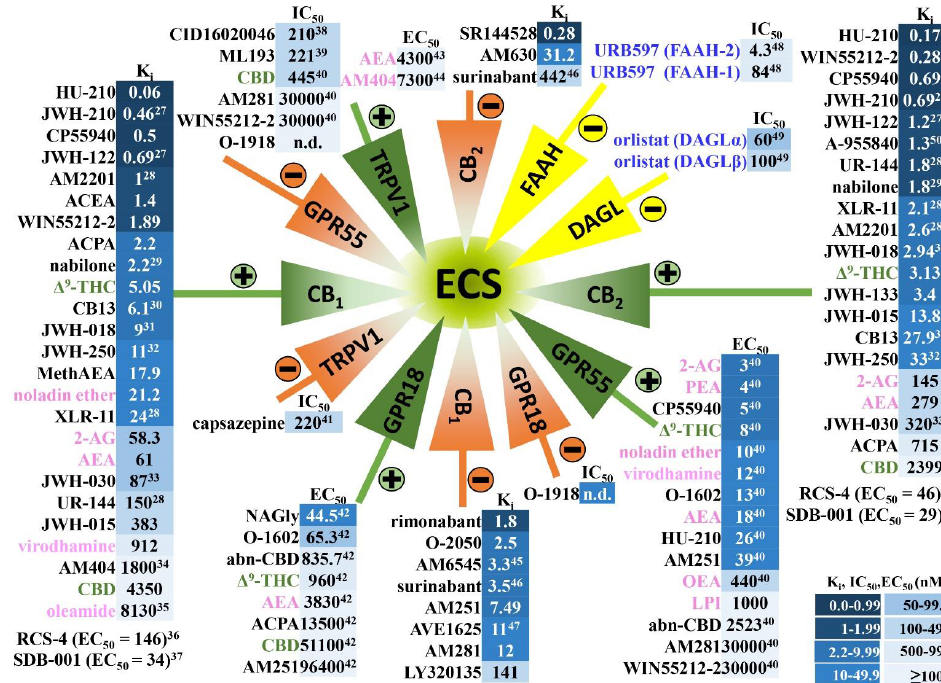
Figure 1. Cannabinoids and their affinities to the classical cannabinoid CB 1 and CB 2 receptors and to other receptors sensitive to cannabinoids, as well as to inhibitors of enzymes involved in the synthesis and/or degradation of AEA and 2-AG. Note that the numbers in the superscript indicate the appropriate reference [15–38]. The figure presents only phytocannabinoids (green font), synthetic cannabinoids and other compounds discussed in this article (black font), endogenous cannabinoids (pink font) and inhibitors of the endocannabinoid synthesis and degradation (blue font) that have been considered in this review. ECS, endocannabinoid system; the “plus sign” indicates agonism and the “minus sign” antagonism, inverse agonism or inhibition versus the respective receptors/enzymes. The intensity of blue color next to the compound is higher the lower the values of K i , IC 50 or EC 50 are (expressed in nM). Based on Pertwee et al. [39] unless stated otherwise (superscript). WIN55212-3, inactive S(–)enantiomer of WIN55212-2 [40]; AM404, an inhibitor of anandamide transport [41]. Abbreviations: ∆ 9 -THC, ∆ 9 -tetrahydrocannabinol; 2-AG, 2-arachidonoylglycerol; abn-CBD, abnormal cannabidiol; ACEA, arachidonoyl-2’-chlorethylamide; ACPA, arachidonylcyclopropylamide; AEA, anandamide; CB 1 , cannabinoid CB 1 receptor; CB 2 , cannabinoid CB 2 receptor; CBD, cannabidiol; DAGL, diacylglycerol lipase; ECS, endocannabinoid system; FAAH, fatty-acid amide hydrolase; GPR18, G protein-coupled receptor 18; GPR55, G protein- coupled receptor 55; LPI, L-alpha-lysophosphatidylinositol; MethAEA, methanandamide; n.d., not determined; OEA, oleoylethanolamide; PEA, palmitoylethanolamide; TRPV1 transient receptor- potential cation-channel subfamily V member 1; URB597, inhibitor of fatty-acid amide